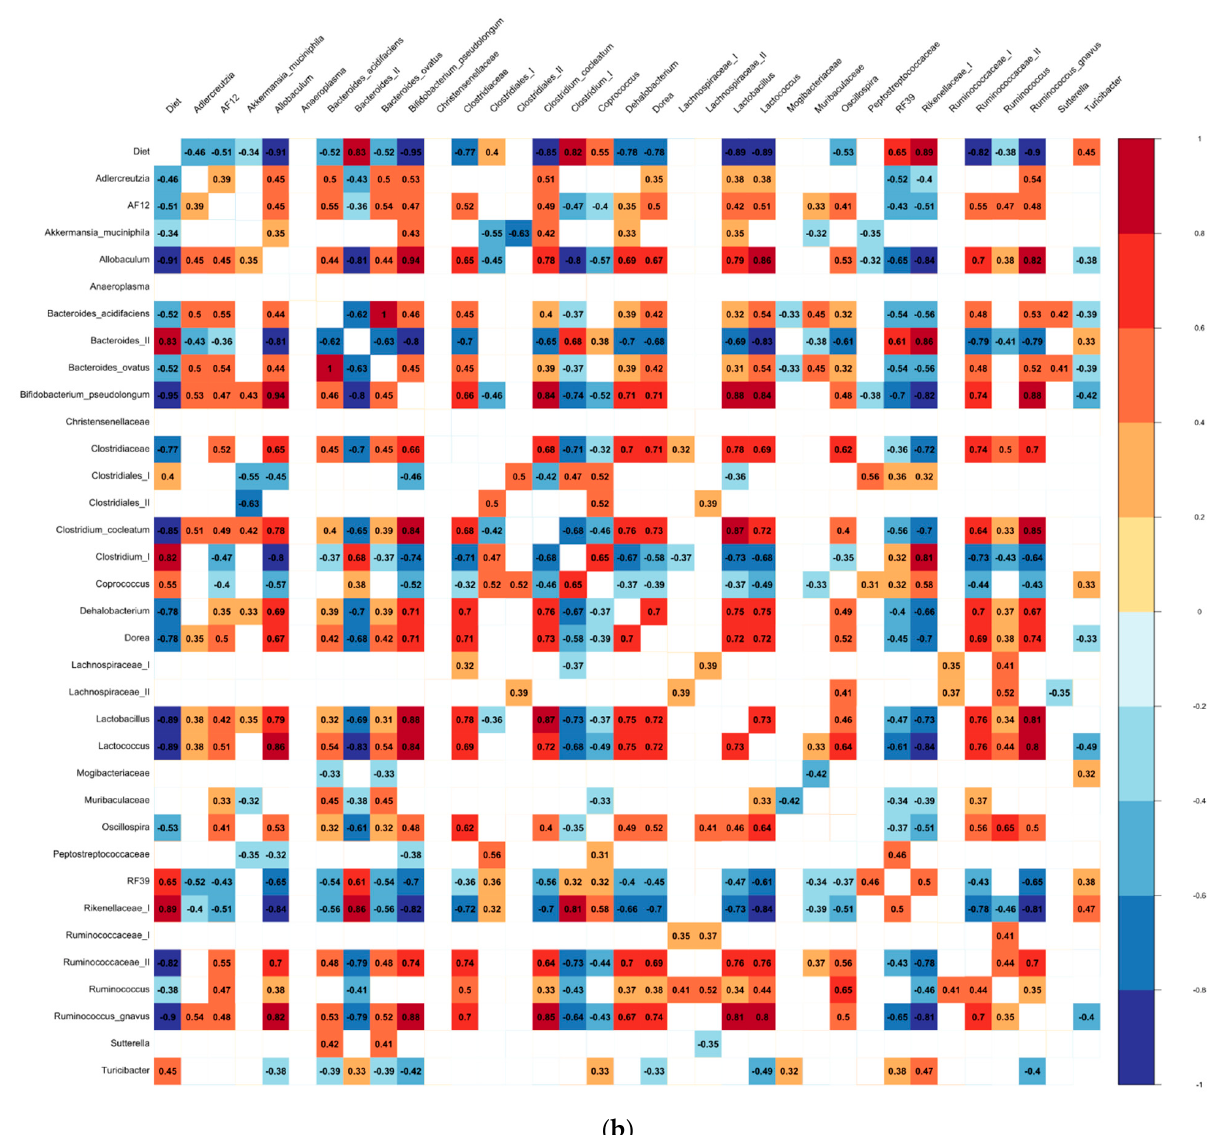
Figure 7. Spearman’s rank-order correlation analysis of the relative abundances of the cecal bacteria identified in the ( a ) female and ( b ) male cohorts. Heatmap represents power of correlation: from the red indicating positive to the blue indicating negative correlation coefficient values. Only correlations with the p -value < 0.05 were included in the correlogram.